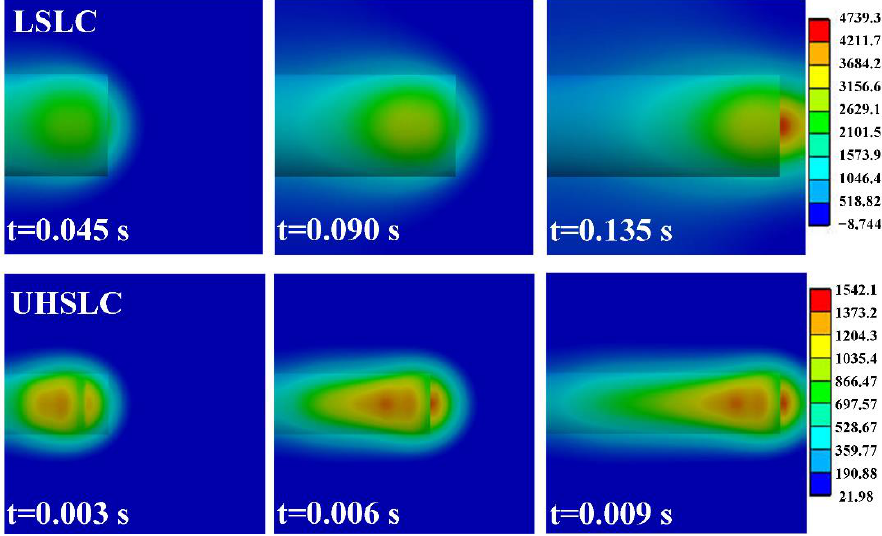
Figure 15. Temperature distribution at different action time LSLC: ( a ) 0.045 s; ( b ) 0.09 s; ( c ) 0.135 s; UHSLC: ( d ) 0.003 s; ( e ) 0.006 s; ( f ) 0.009 s.